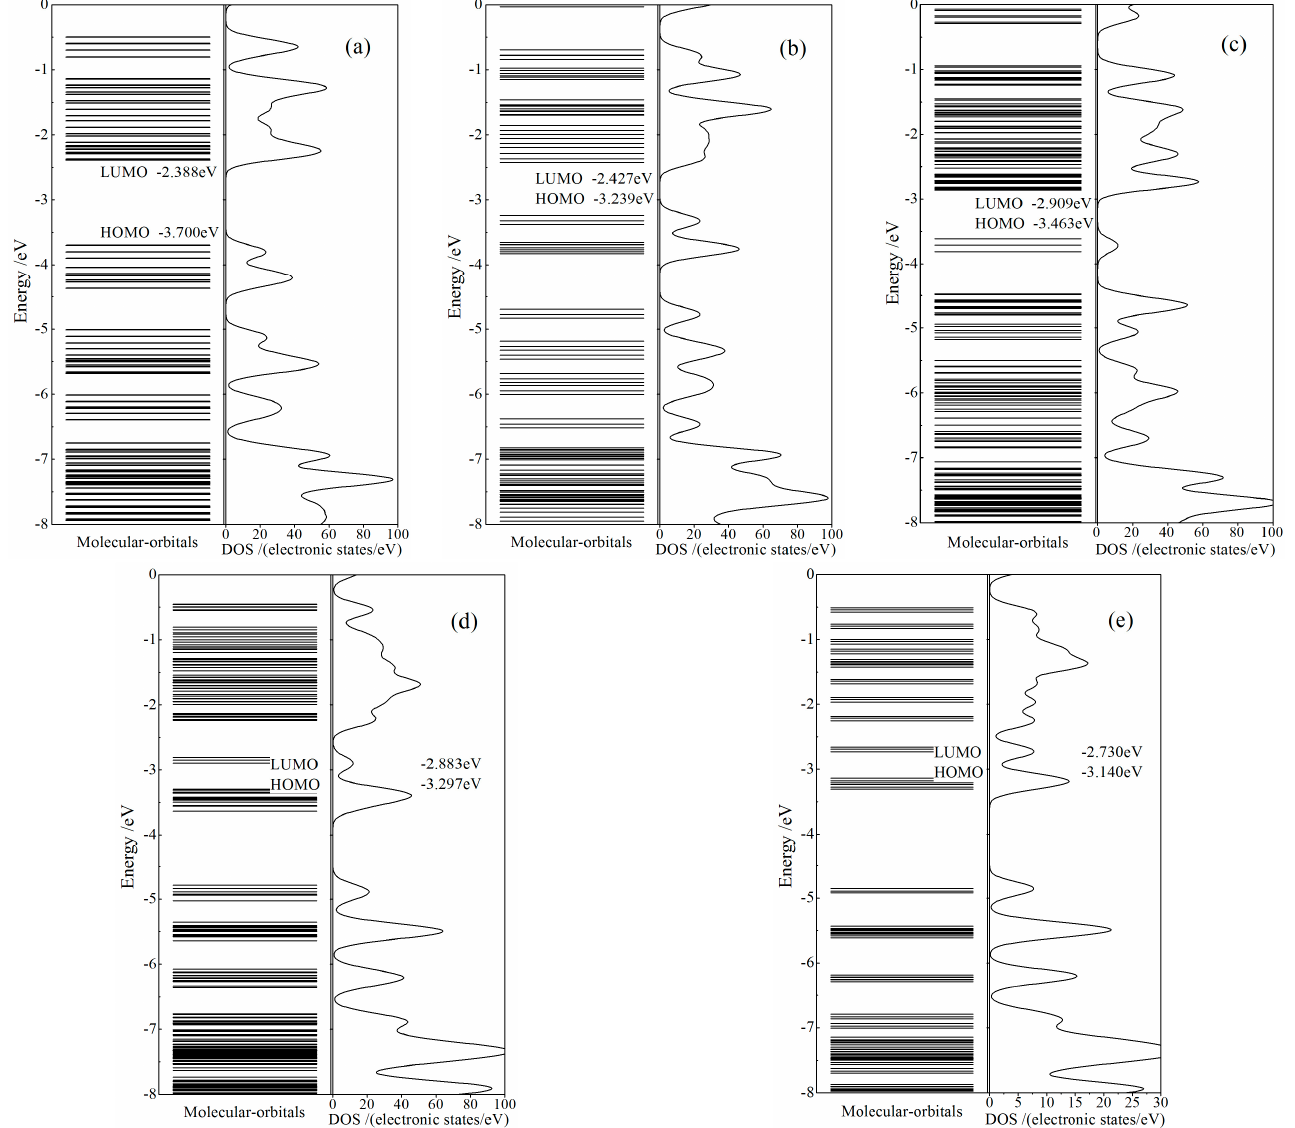
Figure 4. Molecular orbital energy spectra (left panels) and densities of states (DOS, right panels) of CTTC molecule in redox states of ( a ) +2, ( b ) +3 ( c ) +4, ( d ) +5 and ( e ) +6, with vacuum free electron level being referenced as energy zero and HOMO/LUMO being labeled.